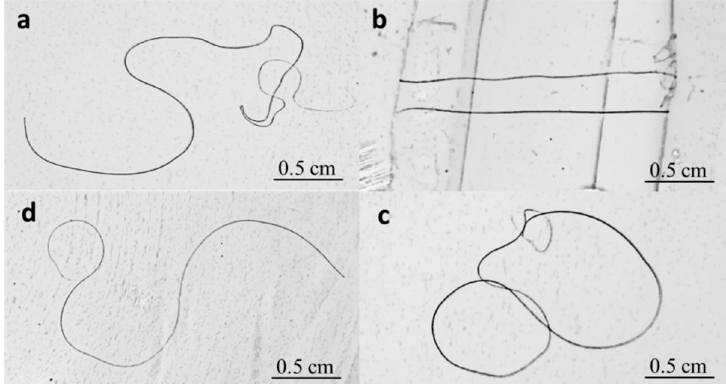
Figure 4. Shape memory effect of yak hair responsive to water, in which ( a ) shows a natural crimped hair, ( b ) denotes the manually deformed yak hair soaked in water, ( c ) displays the temporarily deformed shape of hair after a drying process, and ( d ) shows the recovered crimped shape of hair stimulated by water.